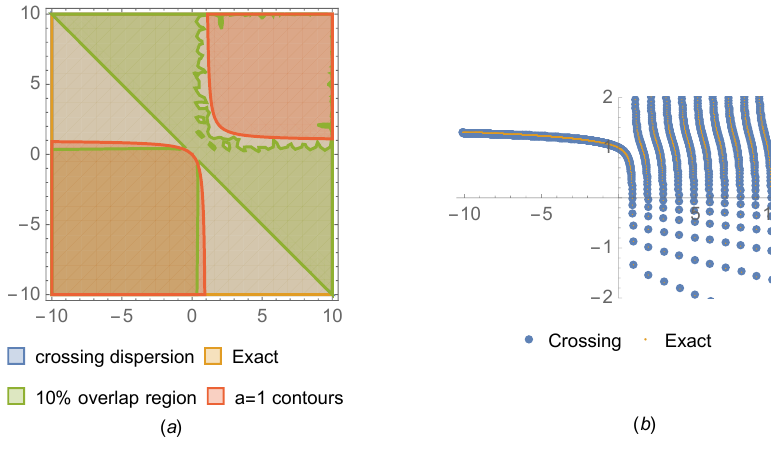
Figure 18. The comparison between the result of the dispersion relation and exact result of the pole subtracted open string amplitude (a)Region in s k max = 100 is the green region(b)The curves of both functions for s 2 = 1